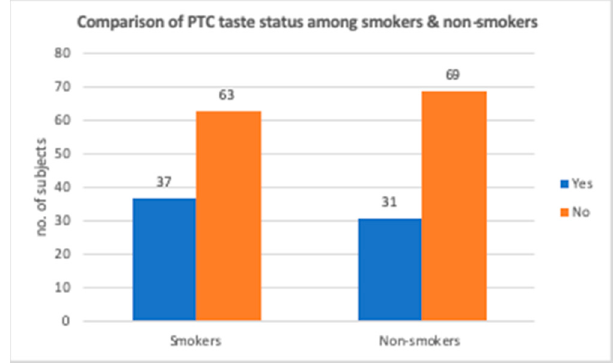
Figure 9. Comparison of PTC taste status among smokers and nonsmokers.